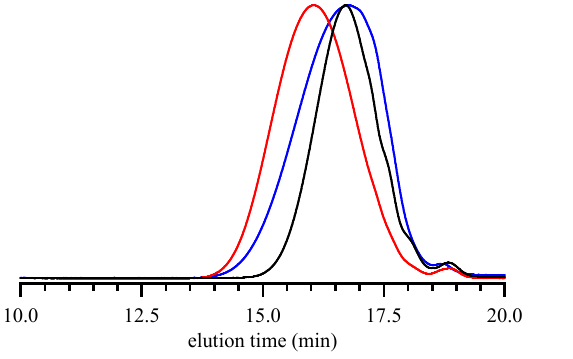
Figure 10. 1 H NMR spectra of (a) 2,7-PCz- co -3,6-PCz, ( b ) PF- co -3,6-PCz, and ( c ) PF- co -2,7-PCz (400 MHz, CDCl 3 ). 3.4. Synthesis of 2,7-PCz-Containing Diblock Copolymers Using Macroinitiators. Finally, we employed iodobenzene-terminated macroinitiators for the SCTP of M2 in order to synthesize 2,7-PCz-containing block copolymers (Scheme 5). Based on our previ- ous study, we reduced the water content as much as possible to prevent the precipitation of the macroinitiator [49]. We first attempted SCTP with iodobenzene-terminated poly-